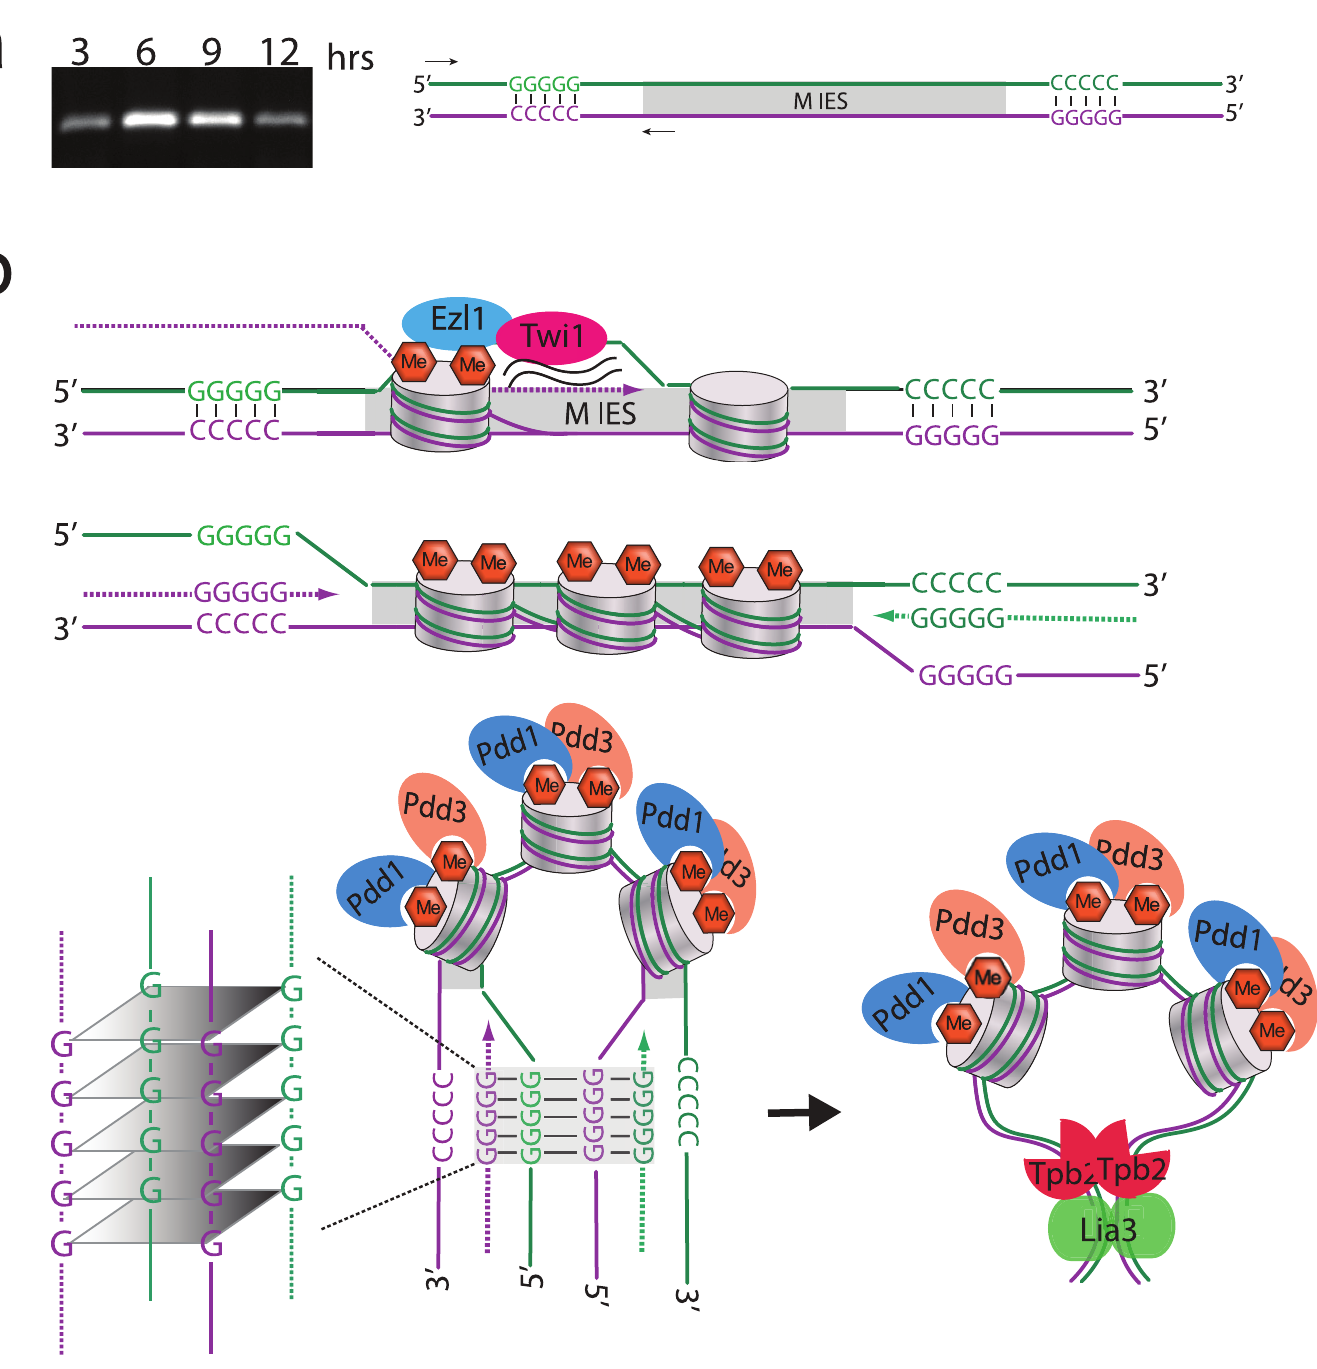
Fig 7. Possible model for how Lia3 determines IES boundaries. (A) RT-PCR across the A 5 G 5 located at the left boundary of the M IES at 3, 6, 9, or 12 hours post-mixing. (B) Model: Shortly after the new macronuclei form, Twi1 bound to scnRNAs interacts with the nascent transcripts being produced across IES. This interaction recruits the histone methyltransferase Ezl1 to induce H3K9/27me at the IES. After H3K9me3 and H3K27me3 marks have been placed, Pdd1, Pdd3 and other chromodomain containing proteins recognize these marks and induce bending in the DNA causing the two ends of the IES to move towards each other. Around this time, transcription is occurring throughout the developing nuclei including across the polypurine tracts located near the boundaries. This opens up the double helix and allows the single stranded DNA to bind to the newly synthesized messenger RNA. Since the two ends are now in proximity to each other, the RNA/DNA hybrids on each side can bind to each other and form a quadruplex. Lia3 binding to the quadruplex either stabilizes the quadruplex interaction thereby keeping the two ends locked together and facilitating Tpb2 in cutting at the correct location or Lia3 recruits